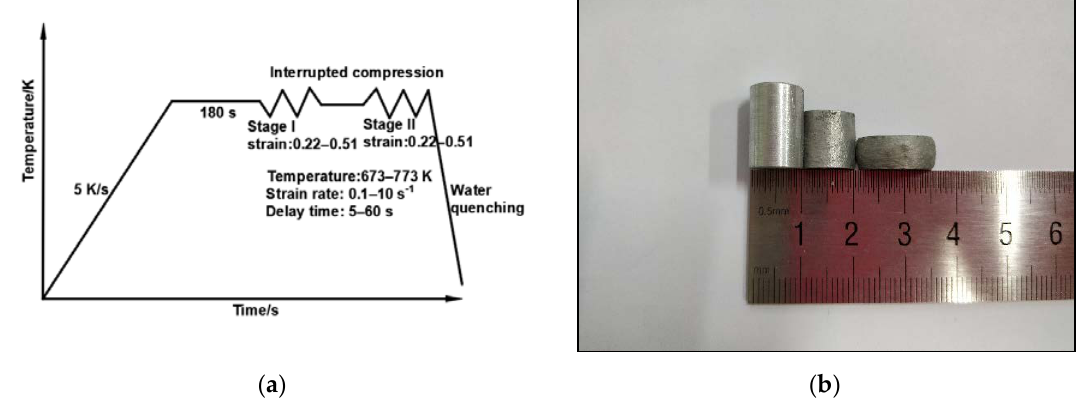
Figure 1. ( a ) Double-pass hot compression test; ( b ) the samples before and after the experiment.